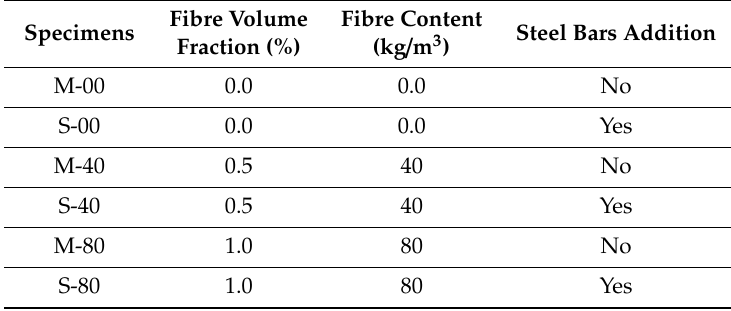
Table 4. Summary of the specimens